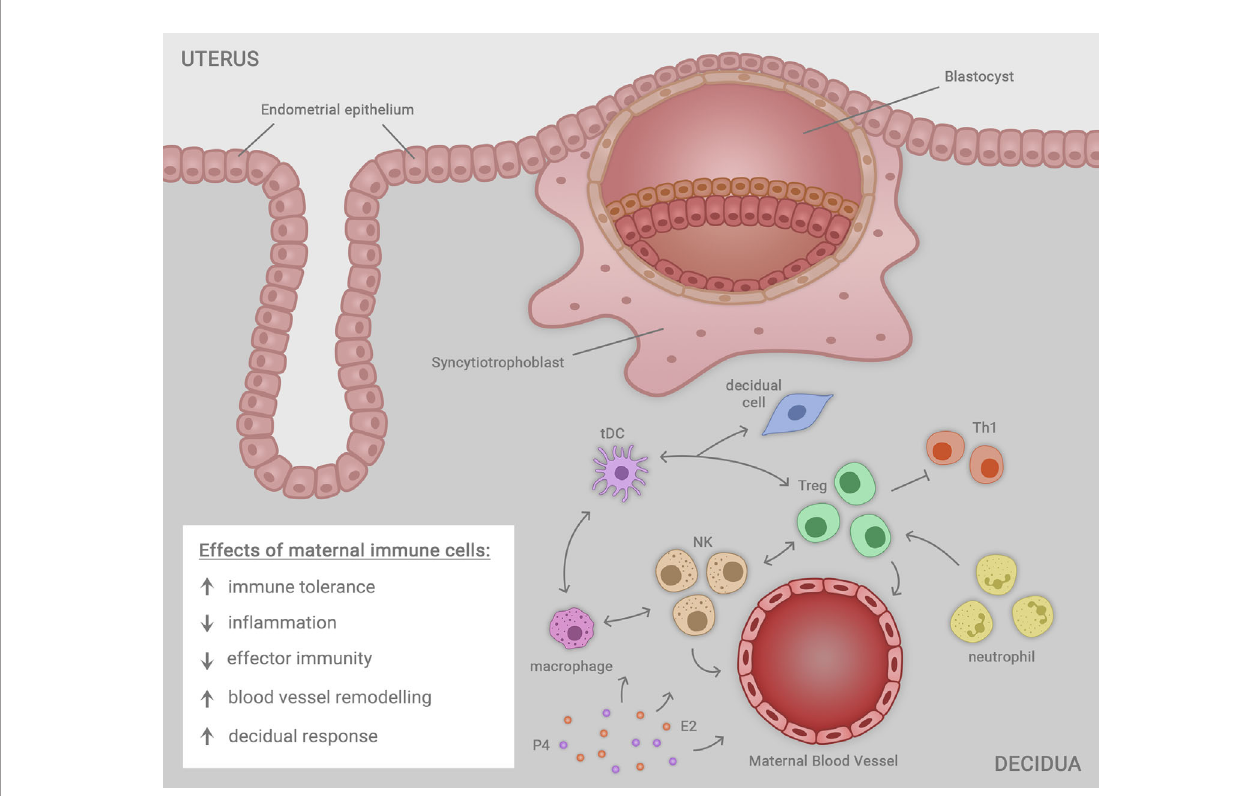
FIGURE 1 | Immune cells including macrophages, natural killer (NK) cells, regulatory T cells (Treg cells), neutrophils and tolerogenic dendritic cells (tDC) residing in the uterine decidua each contribute in a network of cellular interactions to facilitate embryo (blastocyst) implantation and trophoblast outgrowth, required for progression to healthy pregnancy. The decidual immune cells exert a range of regulatory effects on the local microenvironment that each contribute to the success of implantation, ensuring robust placental development that in turn supports healthy fetal growth and development in later gestation. The immune cells together act to mediate immune tolerance, suppress in fl ammation, inhibit effector immunity mediated by T helper type 1 (Th1) cells, promote uterine blood vessel remodeling, and facilitate transformation of uterine stromal cells in the decidual response. Ovarian sex steroid hormones estrogen (E2) and progesterone (P4) act to regulate immune cell populations through direct effects in immune cells, and indirect effects mediated by non-immune cell synthesis of immune-regulatory